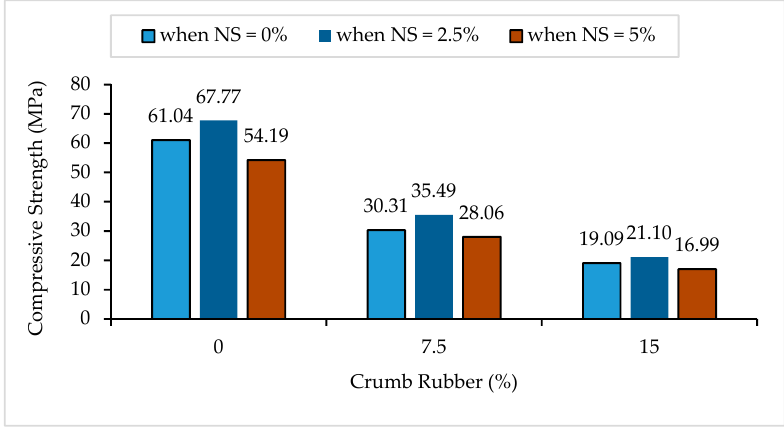
Figure 2. Compressive strength of NS-CRM mixes at 28 days.